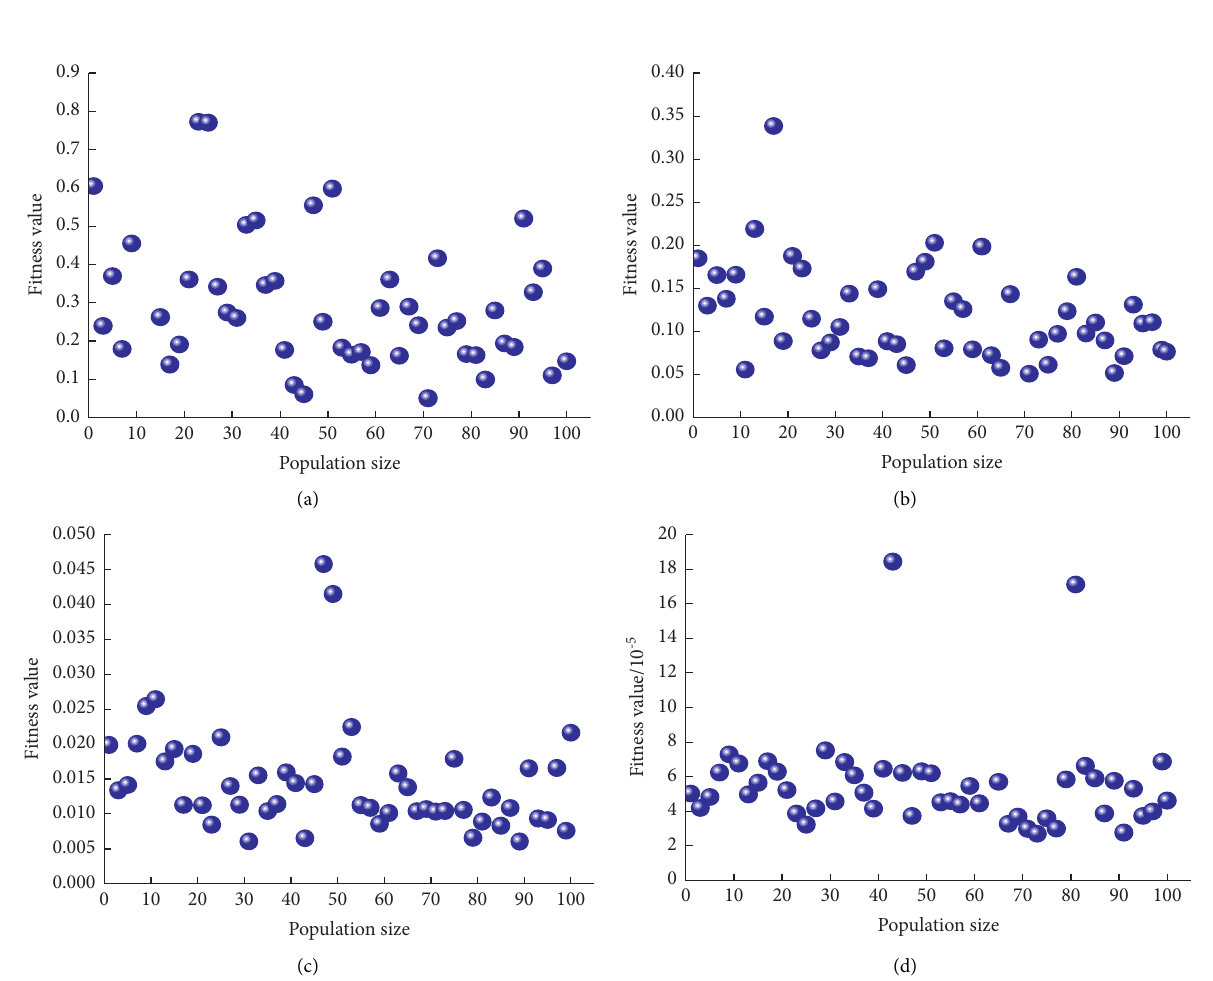
Figure 11: Fitness values with different evolution. (a) 1 st evolution. (b) 2 th evolution. (c) 10 th evolution. (d) 20 th